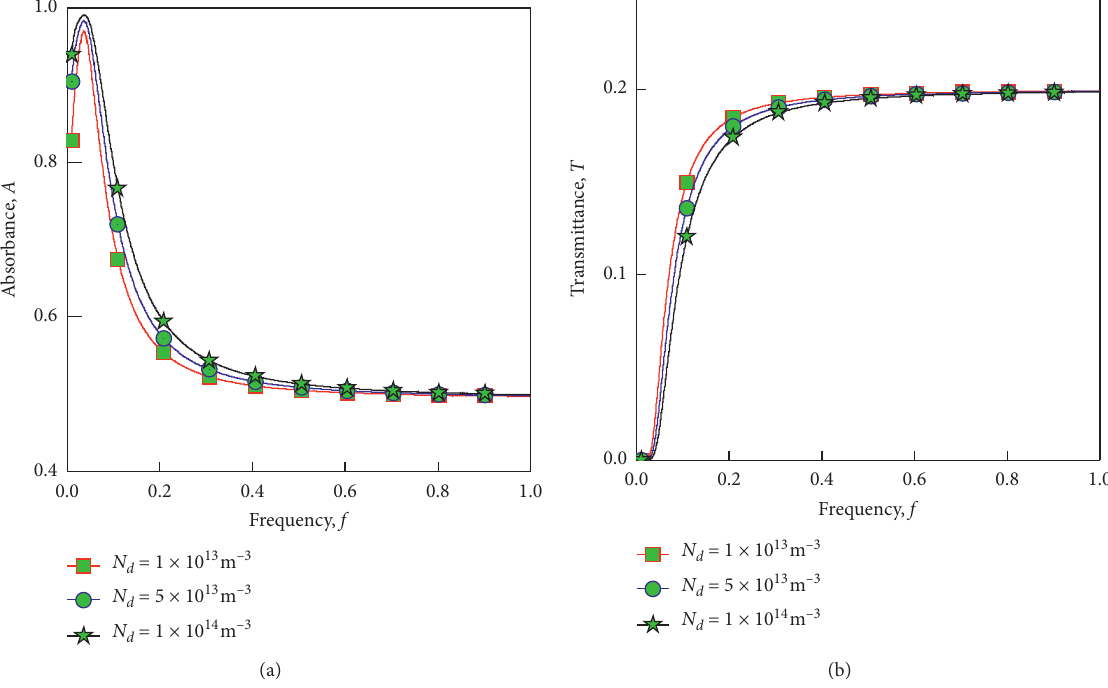
Figure 6: Absorbance and transmittance versus wave frequency for different densities of dust particles in a dusty plasma environment.